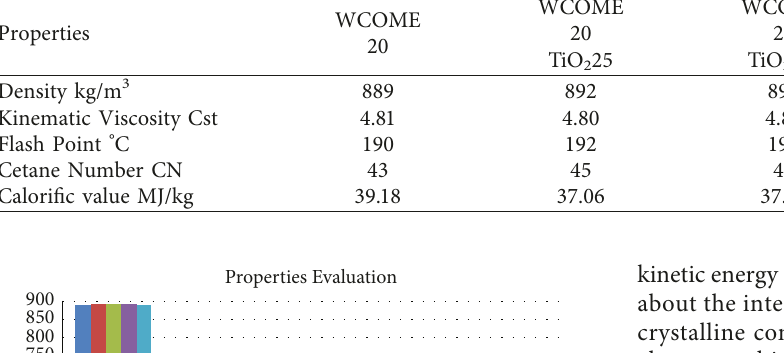
Table 1: The physical and chemical characteristics of mixed biodiesel fuels, both with and without nano-additives. Properties